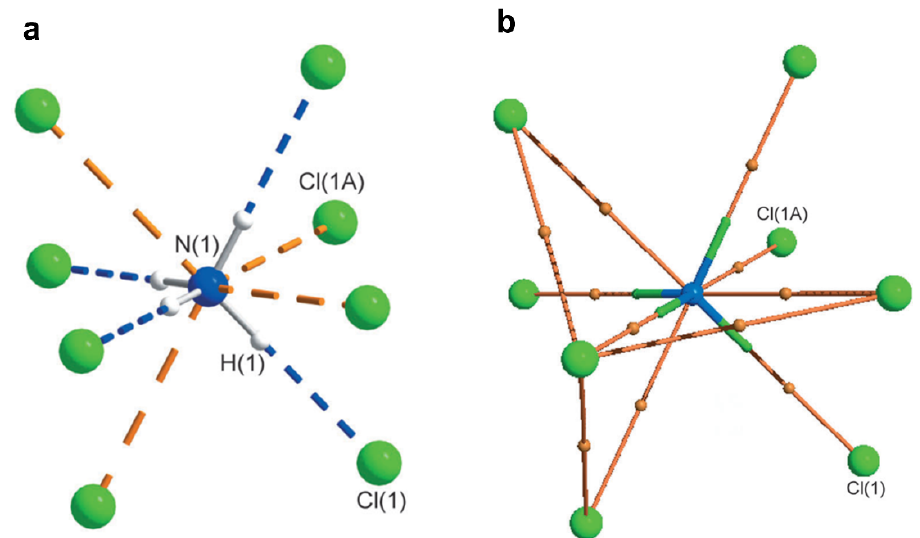
Figure 14. ( a ) Ammonium cation environment in NH 4 Cl (thermal ellipsoids for atoms drawn at probability of 90%); ( b ) bond paths between the two interacting atoms (ions) are shown by orange lines and bond critical points are depicted as orange spheres. Reprinted with permission from reference [80]. Copyright 2014, John Wiley and Sons [79] .